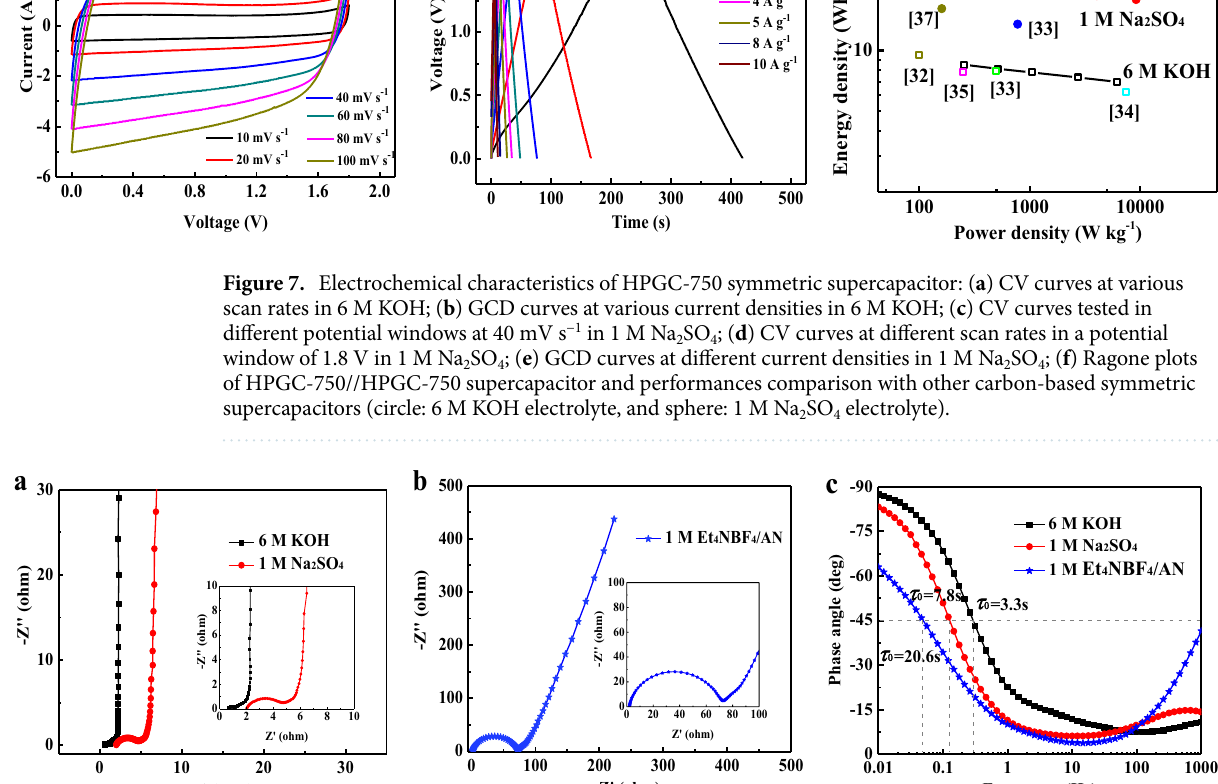
Figure 8. ( a ) Nyquist plots of HPGC-750 symmetric supercapacitors in 6 M KOH and 1 M Na 2 SO 4 , ( b ) Nyquist plots of HPGC-750 symmetric supercapacitors in 1 M Et 4 NBF 4 /AN, and ( c ) Bode phase angle plots of HPGC- 750 symmetric supercapacitors in different